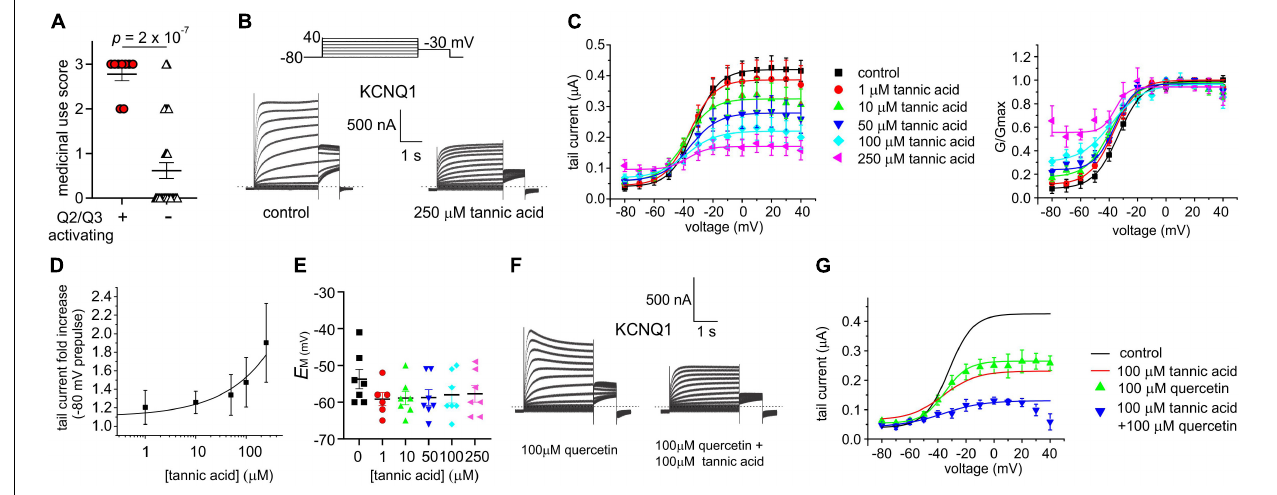
FIGURE 9 | Tannic acid exerts dual effects on KCNQ1. All error bars indicate SEM. n = number of oocytes. (A) Medicinal use score (see Supplementary Table 1 ) for KCNQ2/3 activating versus non-activating plant extracts studied herein. (B) Exemplar TEVC traces of oocyte-expressed KCNQ1 in the absence (control) and presence of tannic acid (250 µ M). (C) Mean tail current (left) and normalized tail current (G/Gmax; right) versus prepulse voltage relationships for traces as in panel (A) at various tannic acid concentrations ( n = 8). (D) Tannic acid dose response for KCNQ1 current increase at –80 mV for oocytes as in panel (B) ( n = 8). (E) Scatter plot of unclamped membrane potential ( E M ) for KCNQ1-expressing oocytes as in panel (B) at various tannic acid concentrations ( n = 6–7). Statistical analysis by one-way ANOVA indicated no statistically significant differences between groups. (F) Exemplar TEVC traces of oocyte-expressed KCNQ1 in the presence of 100 µ M quercetin alone or with tannic acid (100 µ M) ( n = 5). (G) Mean tail current versus prepulse voltage relationships for traces as in panel (F) at various tannic acid concentrations ( n = 5); best fit lines from panel (C) shown for